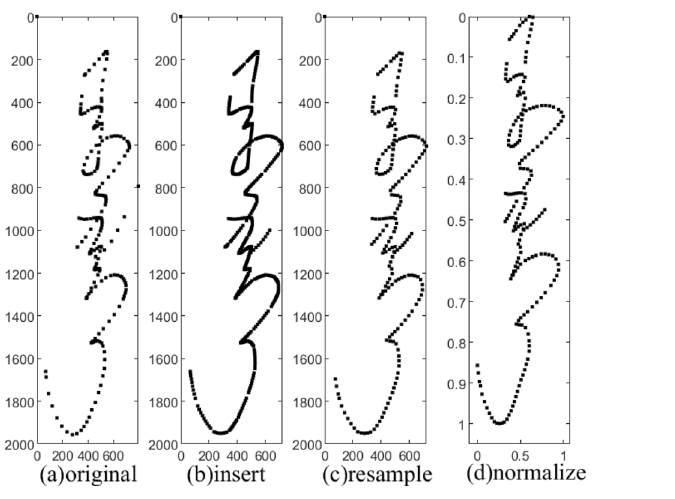
Figure 9. Trajectory data